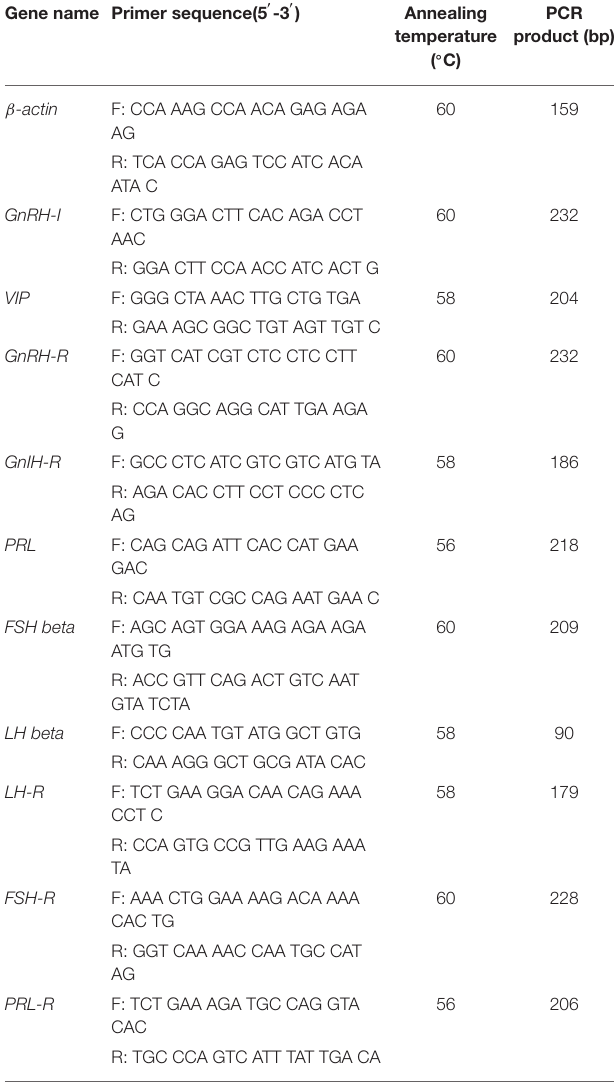
TABLE 2 | Primers corresponding to the purpose genes used in the real-time quantitative PCR assay. Gene name Primer sequence(5 ′ -3 ′